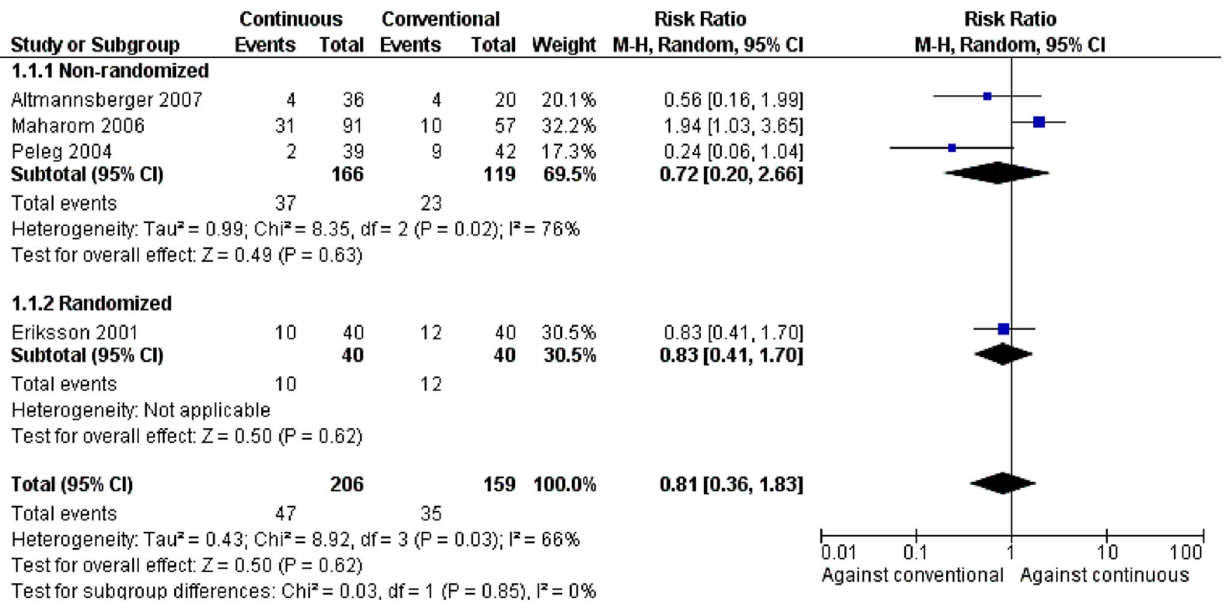
Figure 3. Forest plot depicting the risk ratios (RR) of mortality for patients receiving continuous versus conventional infusion of amphotericin B deoxycholate, stratified by non-randomized and randomized studies. (Vertical line=‘‘no difference’’ point between the two regimens. Squares=risk ratios; Diamonds=pooled risk ratios for all studies. Horizontal lines=95% confidence intervals).